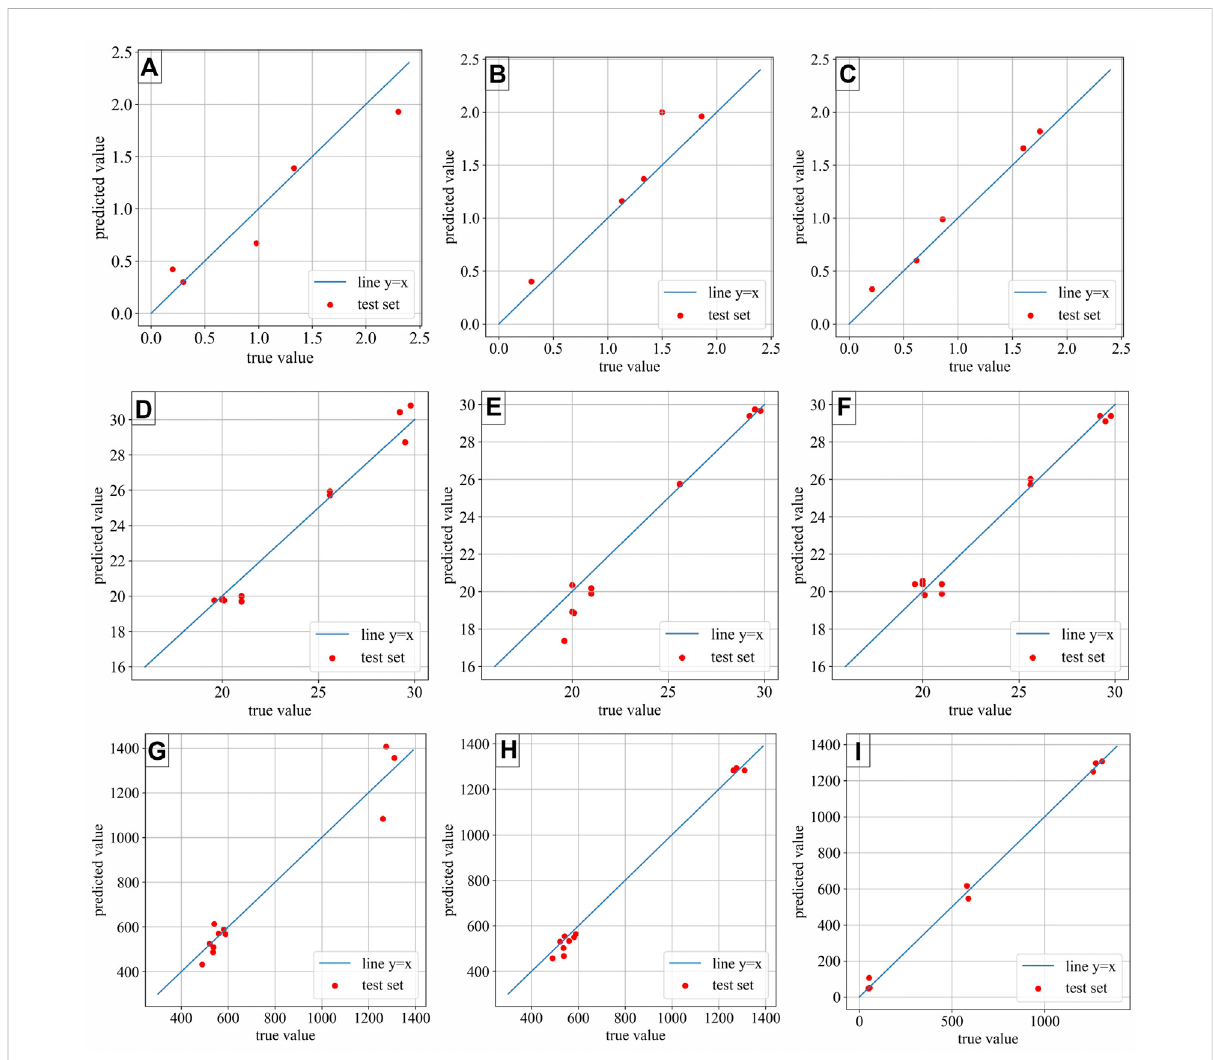
FIGURE 4 Comparison of true and predicted values in the test data set with different machine learning algorithms. (A) Water depth inversion based on BP neuralnetwork; (B) WaterdepthinversionbasedonRandomForest; (C) WaterdepthinversionbasedonLightGBM; (D) SalinityinversionbasedonBP neural network; (E) Salinity inversion based on Random Forest; (F) Salinity inversion based on LightGBM; (G) Lithium concentration inversion based on BP neural network; (H) Lithium concentration inversion based on Random Forest; (I) Lithium concentration inversion based on